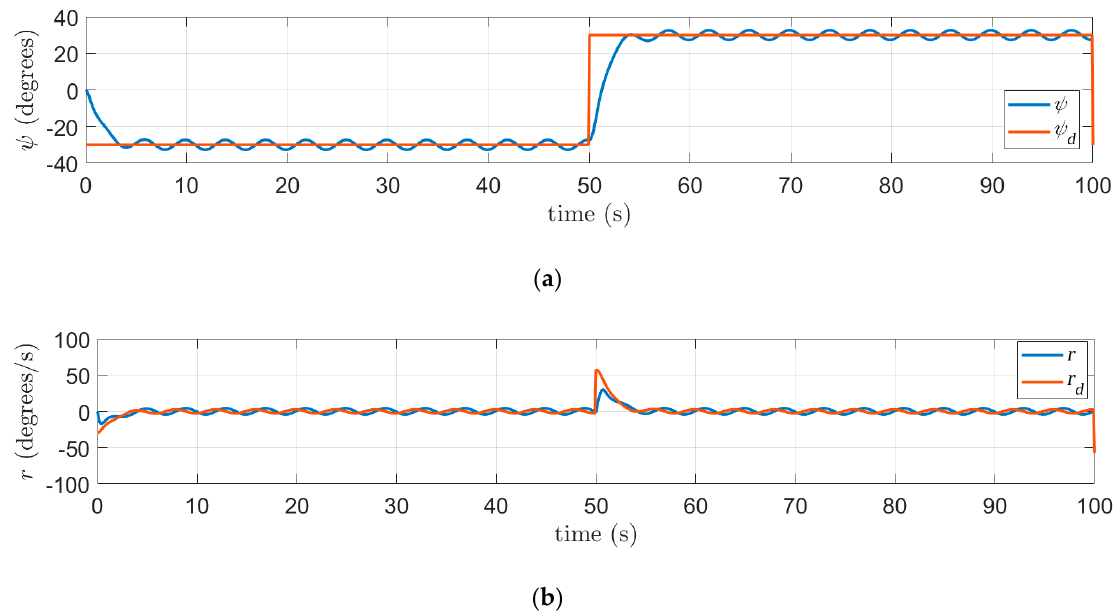
Figure 9. Simulation results of heading control performance without robust control. ( a ) Heading angle is regulated to −30° and 30° . ( b ) Yaw rate is regulated at 0 degrees/s.